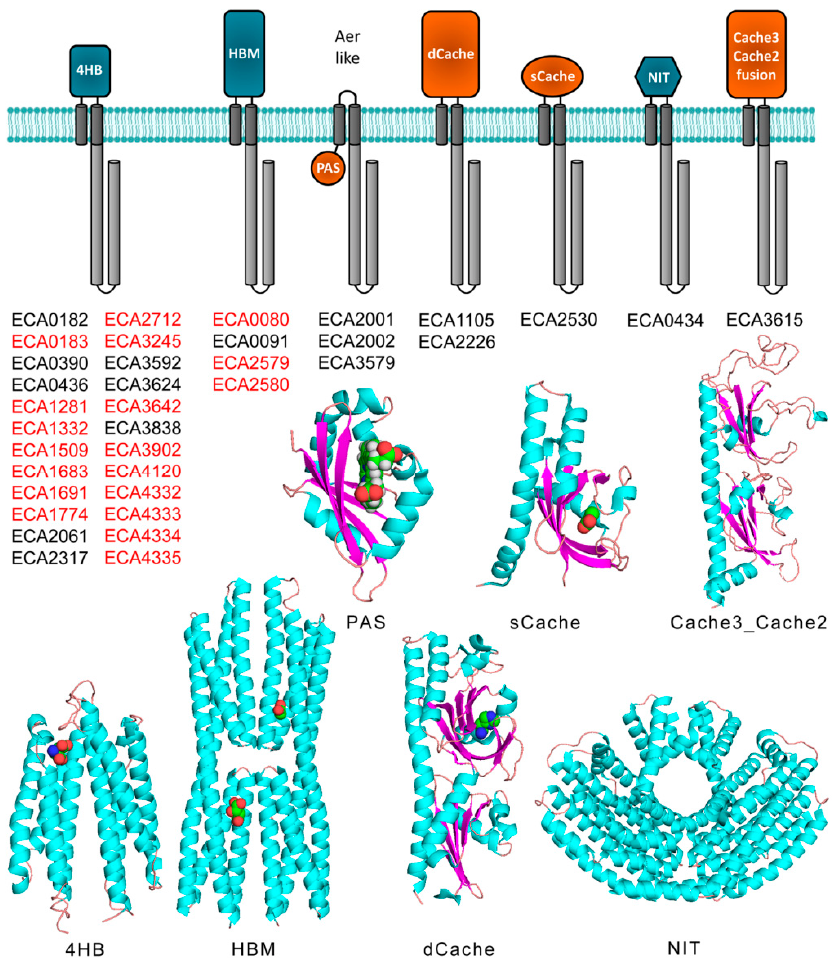
Figure 4. The chemoreceptor repertoire of P. atrosepticum SCRI1043. Ligand-binding domains with α / β folds or parallel helices are shown in orange or blue, respectively. Chemoreceptor names in red indicate receptors with C-terminal pentapeptides. Shown below are representative 3D structures of these domains, namely the structure of Tar-LBD (4HB) in a complex with aspartate (PDB ID: 1vlt), McpS-LBD (HBM) in a complex with malate and acetate (PDB ID: 2yfa), Aer2-LBD (PAS) in a complex with heme (PDB ID: 4hi4), TlpQ-LBD (dCache) in a complex with histamine (PDB ID: 6fu4), PscD-LBD (sCache) in a complex with propionate (PDB ID: 5g4z), NasR-LBD (NIT) (PDB ID: 4akk), and a homology model of the ECA3615-LBD (Cache3_Cache2 fusion) generated by SwissModel [48] using PDB ID 4avf as template.